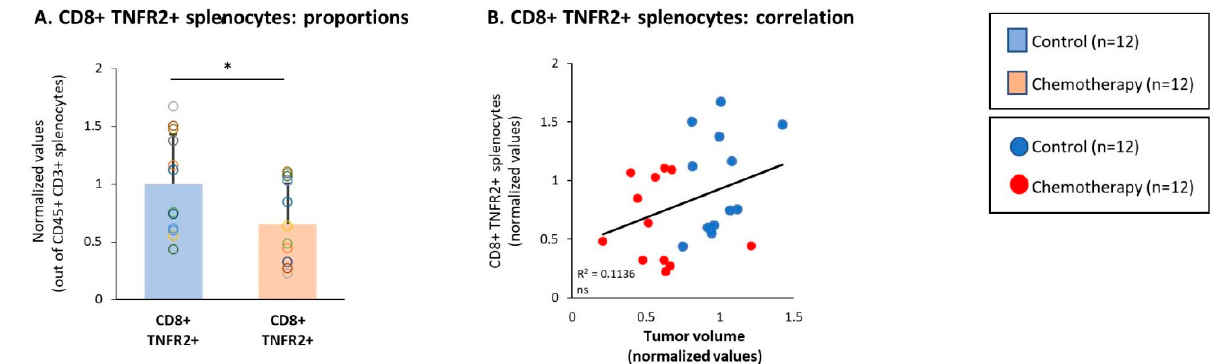
Figure 9. Chemotherapy reduced the proportion of CD8+ TNFR2+ splenocytes, accompanied by the absence of CD8+ TNFR2+ PD-1+ splenocytes. Murine 4T1 TNBC cells were syngrafted to BALB/c mice in the presence of chemotherapy or a vehicle control; procedures and analyses were performed as described in Figure 3. CD8+ TNFR2+ splenocytes, gated out of the CD45+ CD3+ splenocytes. ( A ) Proportions of the CD8+ TNFR2+ splenocytes. ( B ) CD8+ TNFR2+ splenocytes correlated with tumor volumes. CD8+ TNFR2+ PD-1+ splenocytes were not detected prior to or after chemotherapy (data not shown). In the proportion and correlation analyses, the average value of the vehicle-treated group in each biological repeat was given the value of 1 and the values of all mice analyzed in that repeat were normalized accordingly. The value of each mouse is presented as a dot. * p < 0.05, ns: not significant (two-tailed unpaired Student’s t -test; correlation analyses: Pearson; T.DIST).